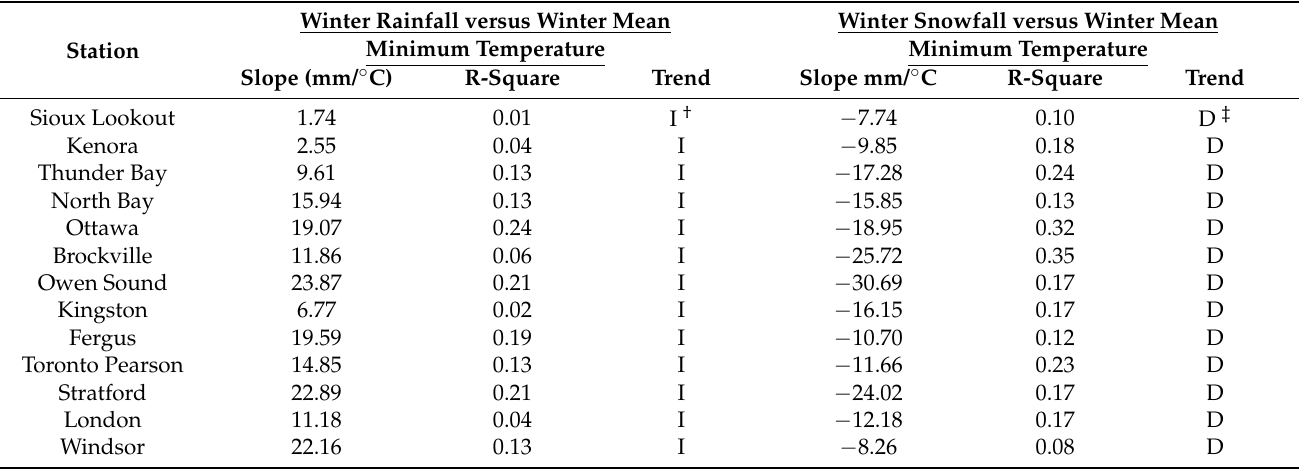
Table 5. Linear regression and correlation statistics for winter rainfall and winter snowfall versus winter mean minimum